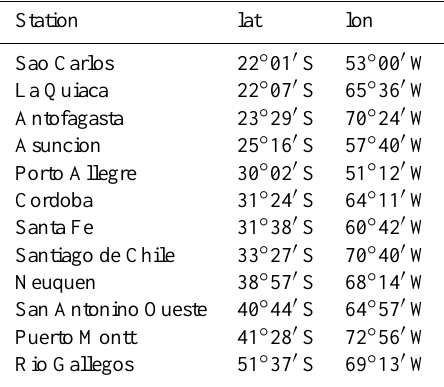
Table 2. Locations used for the comparison between the ERA40 + CCLM simulation and observations. The stations are entering the gridded observational products used for comparison (CRU and